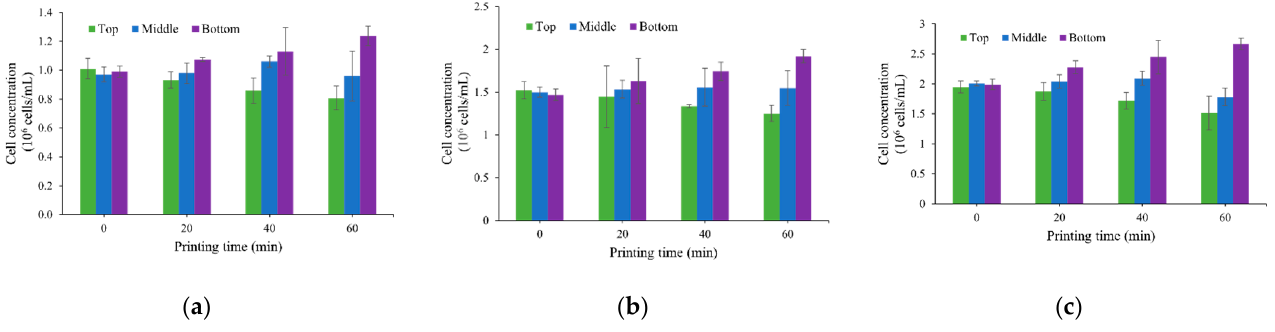
Figure 3. Cell concentrations measured at different regions after different printing time using the bioink composed of 1.5% ( w / v ) sodium alginate and a cell concentration of ( a ) 1 × 10 6 cells/mL, ( b ) 1.5 × 10 6 cells/mL, and ( c ) 2 × 10 6 cells/mL.